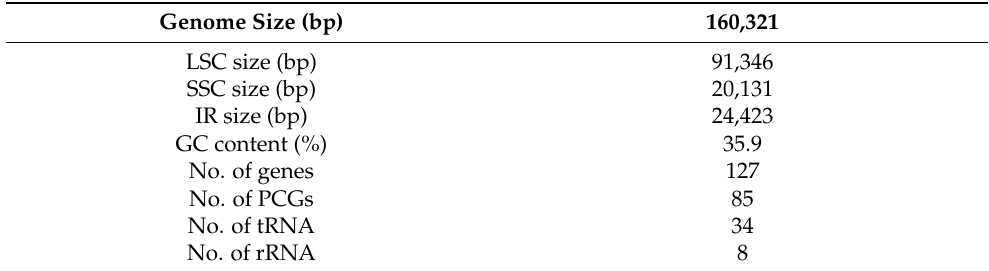
Figure 2. Circular map of the chloroplast genome of F. simplicissima m3. Genes located outside of the circle are transcribed counter-clockwise, while genes shown inside are transcribed clockwise. The darker gray in the inner circle indicates GC content, and the lighter gray corresponds to AT content. Genes marked with the sign ‘ * ’ are the gene with intron. Table 1. Summary of the chloroplast genome of Ficus simplicissima m3 species.